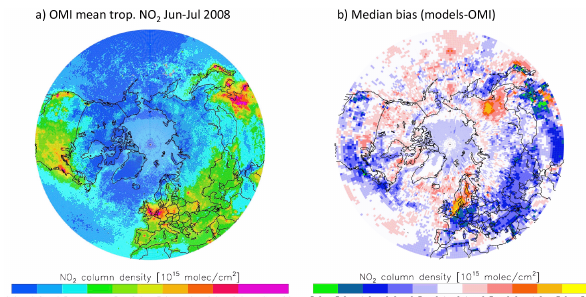
Figure 12. (a) OMI tropospheric column NO 2 and (b) median of the model biases, both for 18 June–15